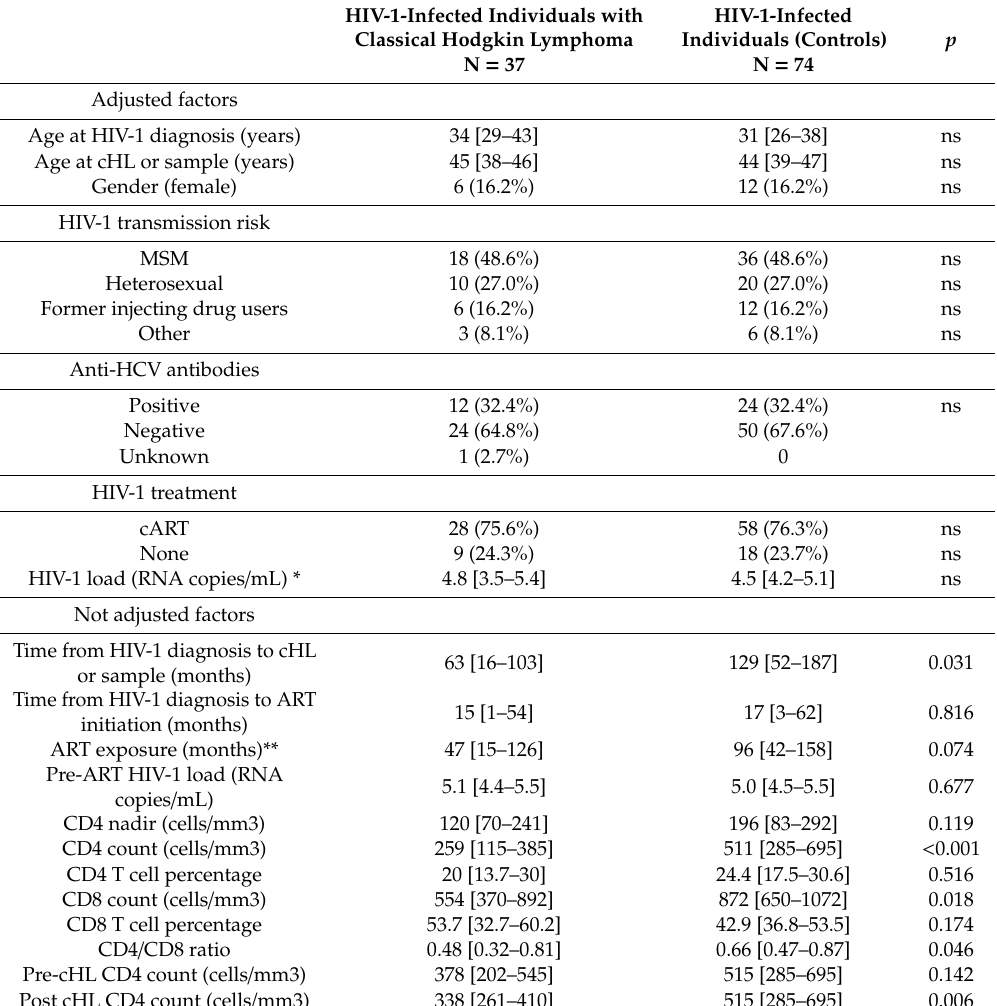
Table 1. Immunovirologic characteristics of the HIV-1-infected individuals at cHL diagnosis. HIV-1-Infected HIV-1-Infected Individuals with Classical Hodgkin Lymphoma Individuals (Controls) N = 37